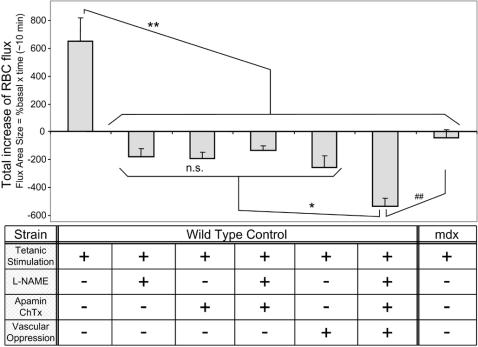
Comparison of total RBC flux increase in control and mdx mice in response to tetanic stimulation and pharmacological agents.Total RBC flux increase was calculated as an integral of % change in RBC flux after stimulation. Tetanic stimulation increased the flux to 653.2 (%×min, far left column) in control mice. Administration of L-NAME (2nd column), apamin plus charybdotoxin (3rd), or vascular oppression (5th) suppressed the increase in RBC flux. When all the above treatments were combined, RBC flux was further suppressed (6th). The level of ischemia in the control mice receiving all the combination (6th) was more severe as compared to mdx mice (far right). N = 8 mice, for each treatment. * and **: Statistically significant difference from all other treatments (p<0.05 and 0.01, ANOVA). ##: Statistically significant difference between the two groups (p<0.01, t-test). Standard error bars are added to the histogram.